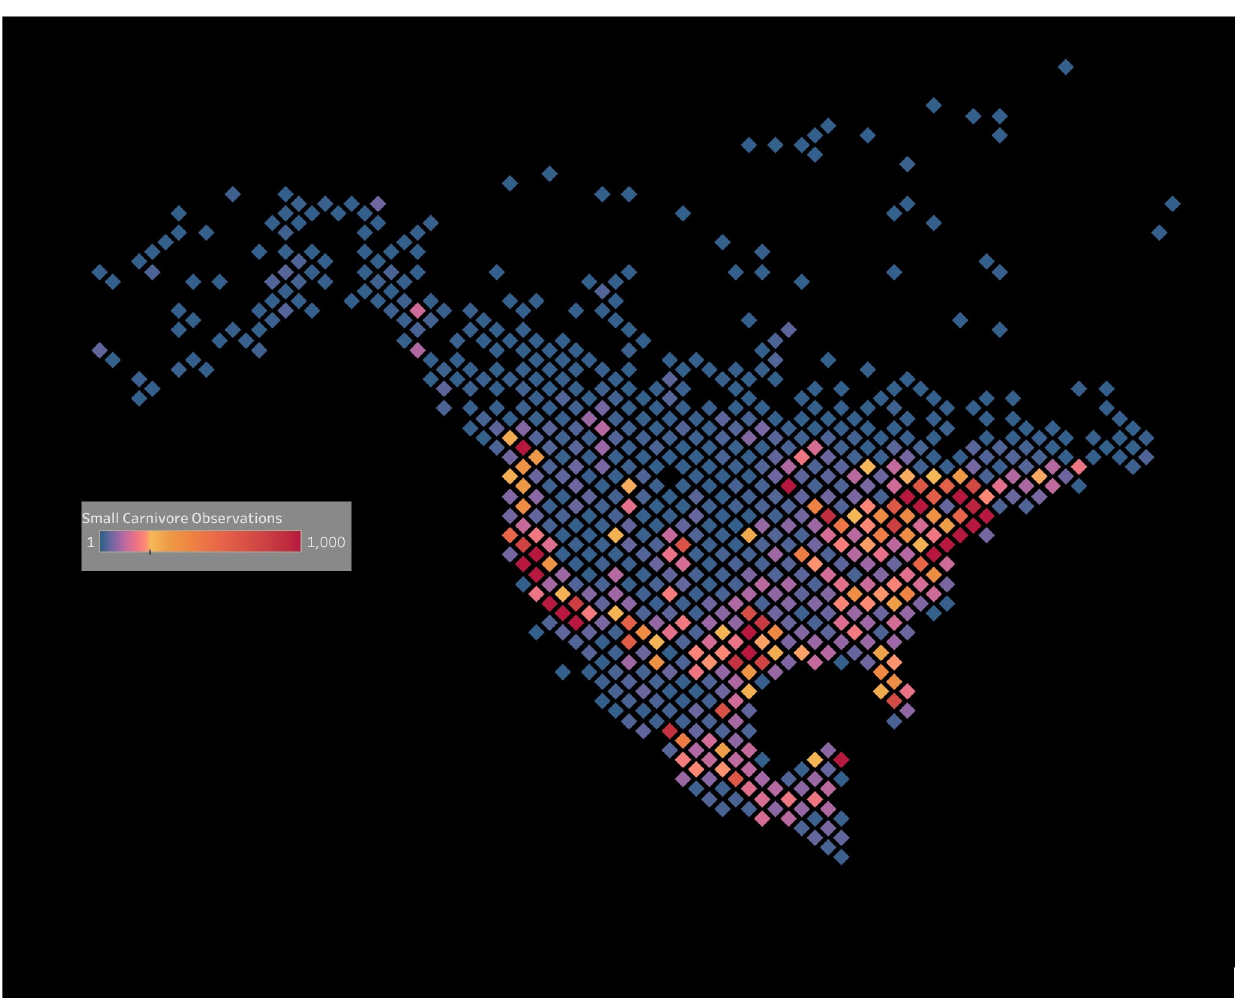
Fig 5. Density map of 83,981 iNaturalist records of small carnivores recorded since 2000 in North